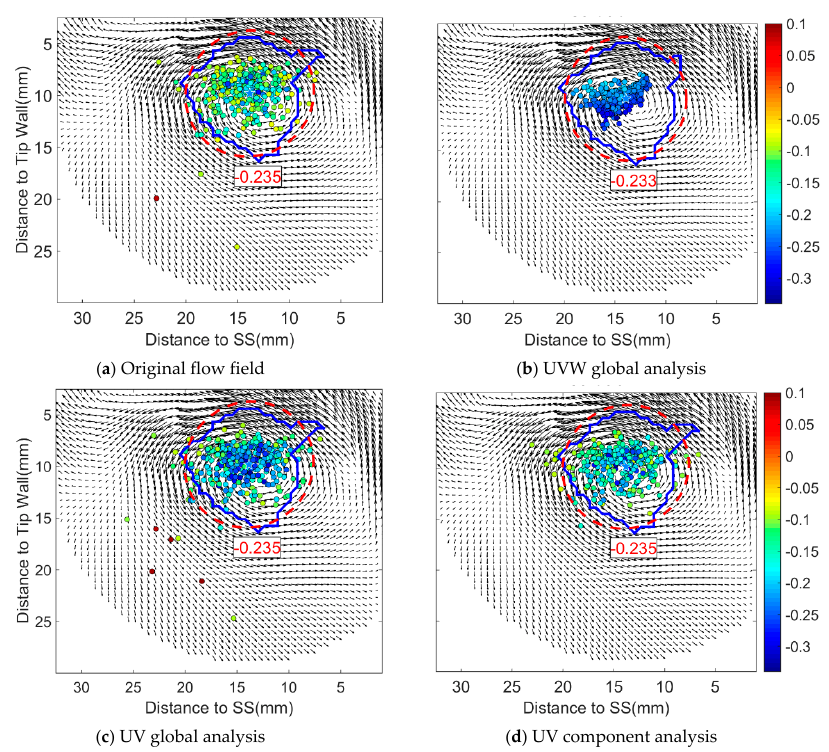
Figure 20. Vortex distribution in the reconstructed flow field that represents 95% energy of the original flow field at L/c = 1.1. The color of the points shows the vortex circulation.